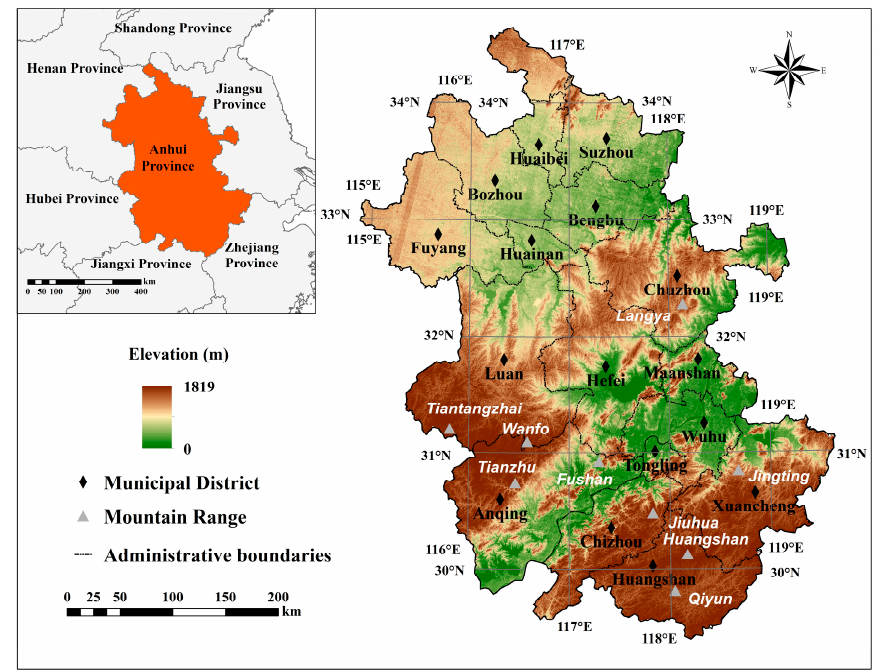
Figure 1. Location of Anhui